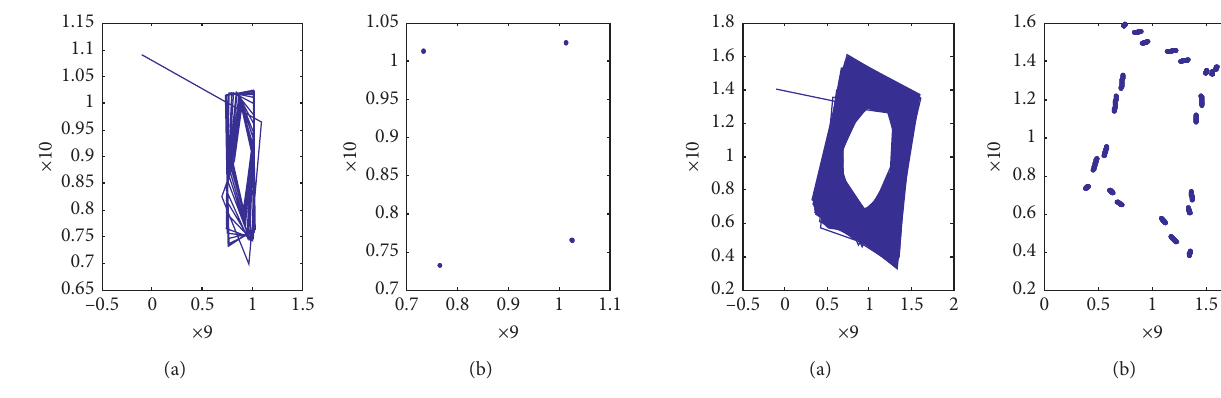
Figure 24: ω � 174 and k � 0with the Coulomb model when w t ∈ 0 . 05 0 . 0581 􏼂 􏼃 . (a) Phase trajectories. (b) Poincare maps.